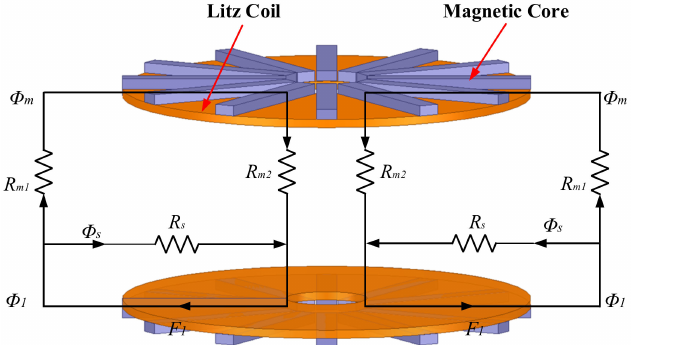
Figure 13. Planar circular magnetic coupler reluctance